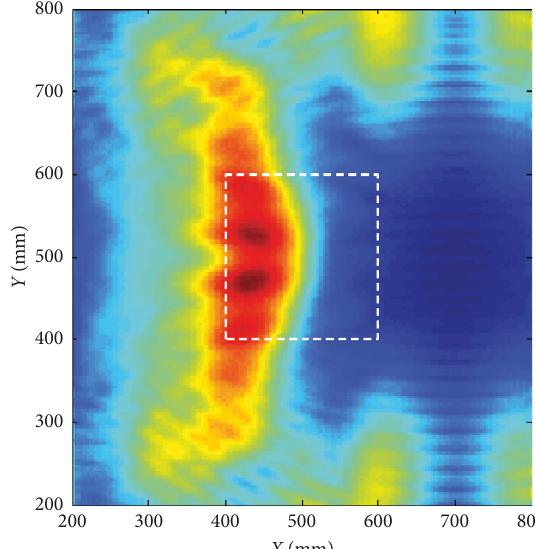
Figure 5: SAFT imaging results (finite element simulation).